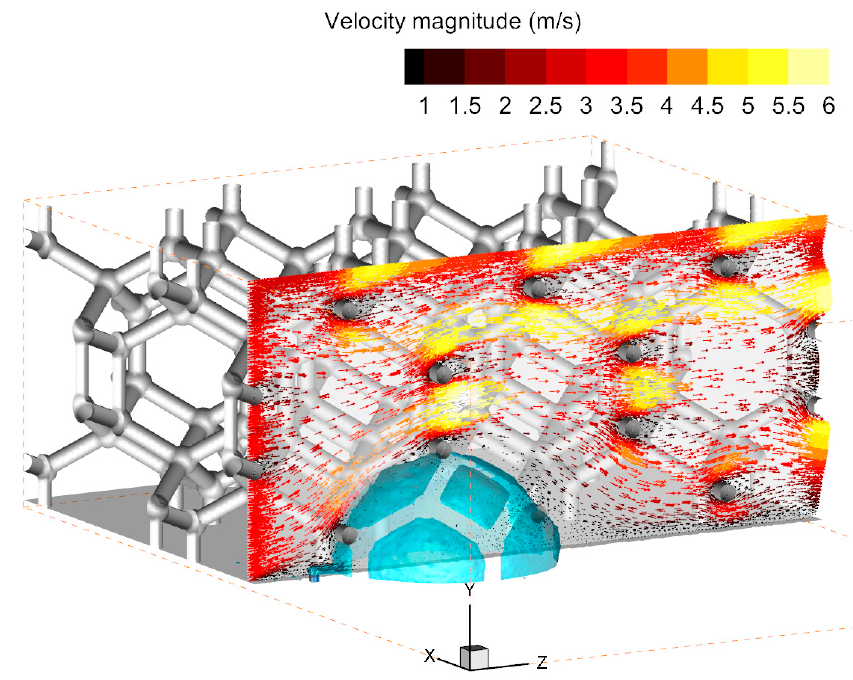
Figure 10. Distribution of velocity around the attached water droplet at t = 60 ms, air flow rate 3 ms − 1 in hydrophobic foam.